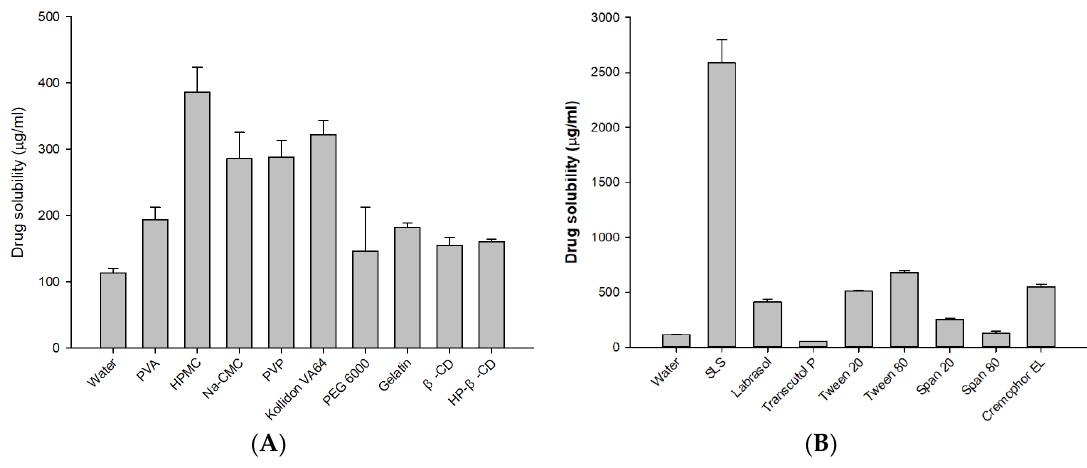
Figure 2. Solubility of atorvastatin calcium (ATO) in a different ( A ) polymer and ( B ) surfactant solutions (1% w / v ) ( n = 3).